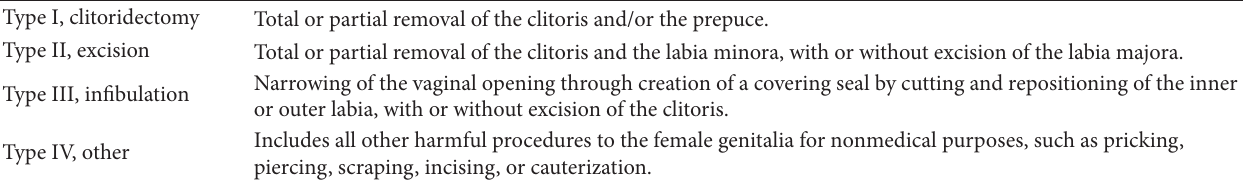
Table 1: Classifications of FGM/C according to WHO